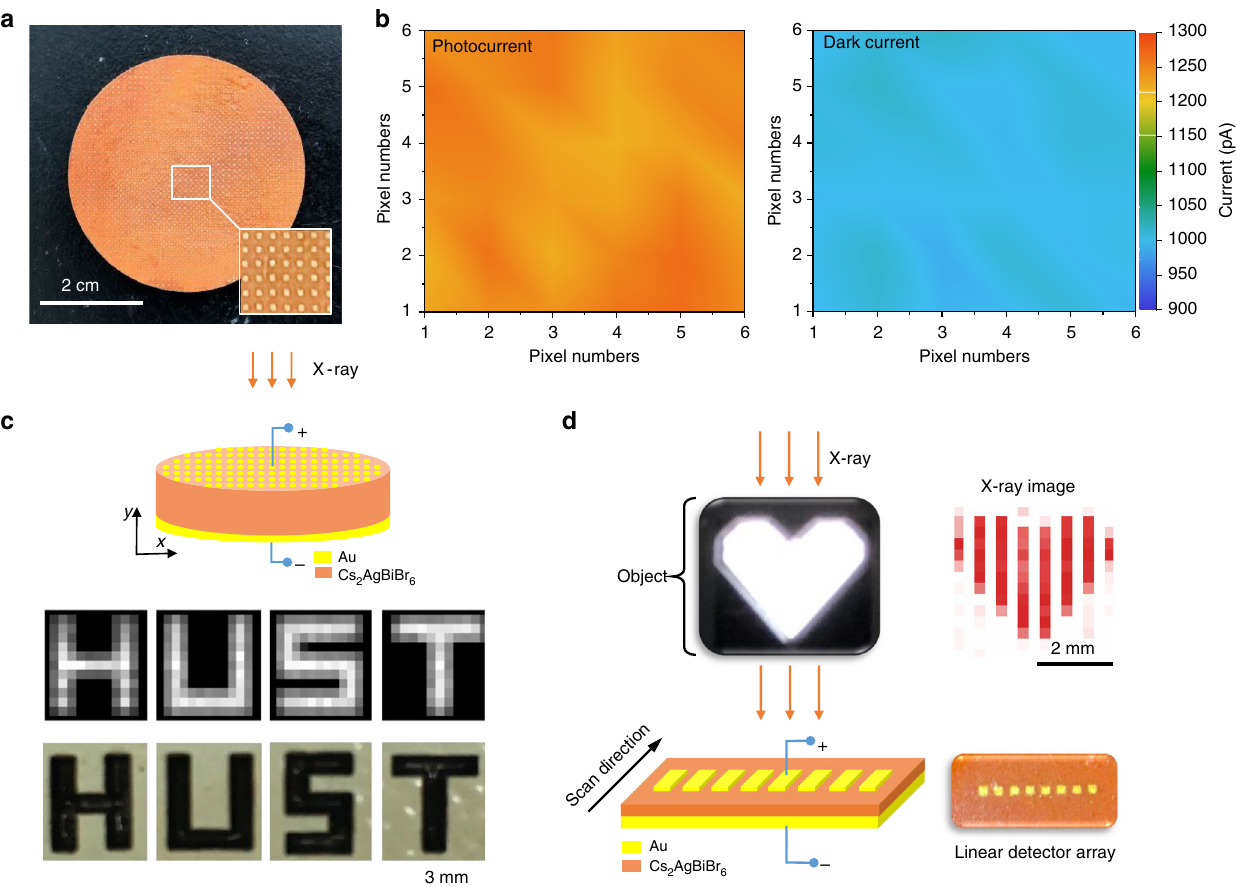
Fig. 5 Imaging applications of Cs 2 AgBiBr 6 wafer X-ray detector. a The fabricated multi-pixel wafer-based detector. b Mapping of photocurrent (left) and dark current (right) for the wafer with 6 × 6 pixels as the region of interest. c The Schematic illustration of the imaging process, and the X-ray image (top) and the optical image (bottom) of ‘ HUST ’ symbol. d Optical image and X-ray image of the heart-shaped logo obtained by the linear detector array, the dose rate for imaging is 138 μ Gy air s − 1 , and the scanning mode, as well as the linear detector array is shown at the